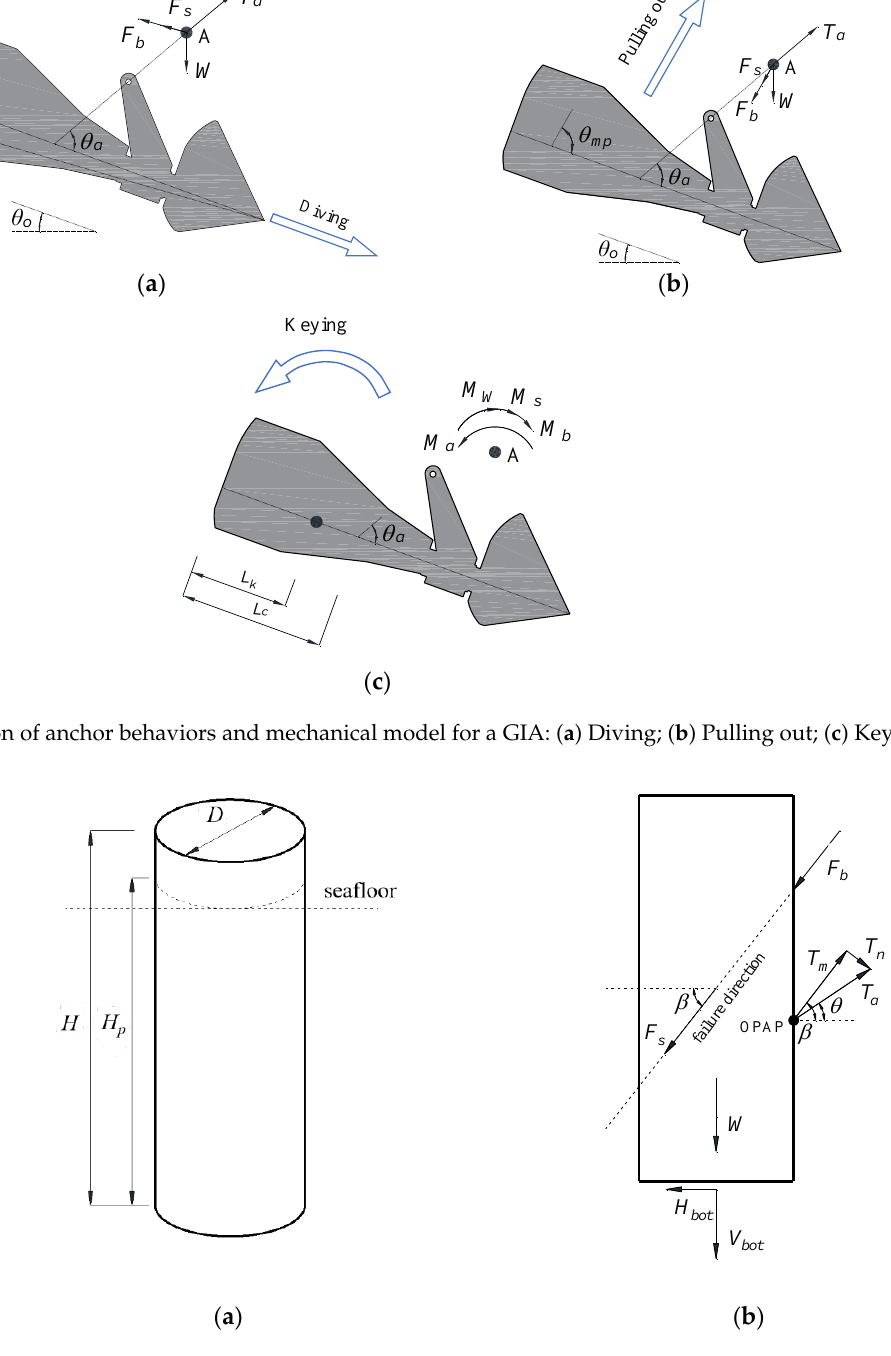
Figure 5. Geometry and mechanical model of an anchor pile or suction anchor: ( a ) Geometry; ( b ) Mechanical model.